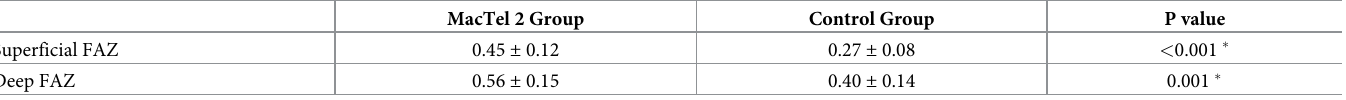
Table 2. Foveal avascular zone (FAZ) area (mm 2 ) of the superficial and deep plexuses determined by optical coherence tomography angiography in the MacTel 2 group and control group.